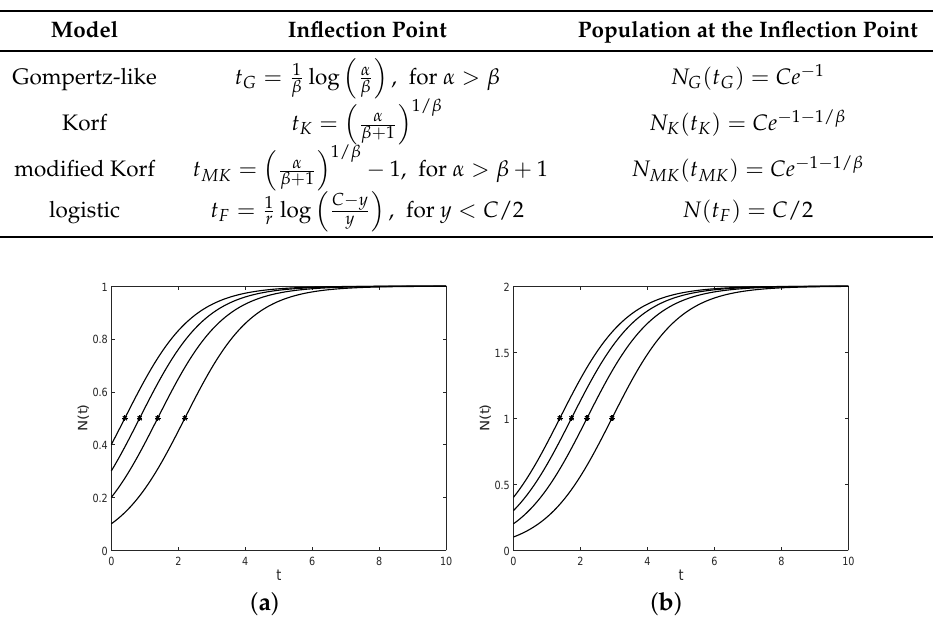
Figure 3. The logistic curve and the inflection point (asterisk point) for ( a ) C = 1, ( b ) C = 2, and y = 0.1,0.2,0.3,0.4,